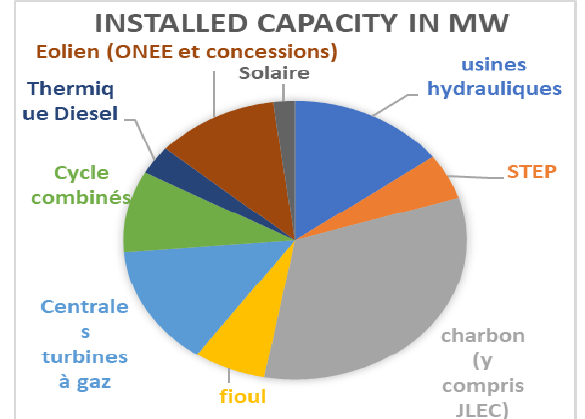
Figure 1. Installed power in MW by ONE in Morocco (Source http://www.one.org.ma)